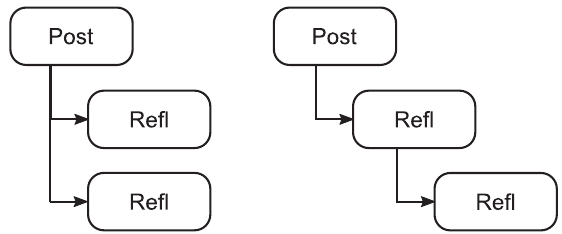
FIG. 1. Structure of forum transcript data. The CN data largely shows a post with a single reply layer (left), in contrast to studies where more nested structure is retained and informs the network construction